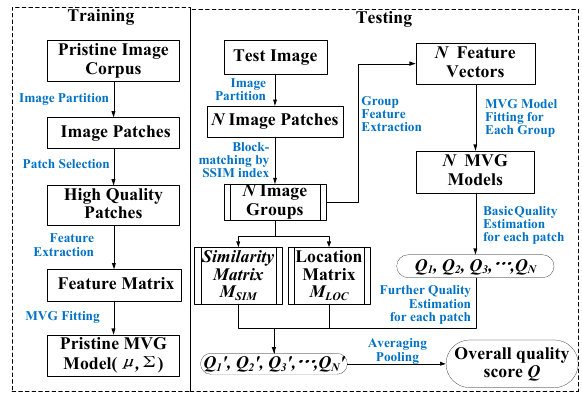
Figure 7. Processing flow of the BM-IQE model. The training stage is required to run before the testing stage. The output model ( μ , Σ ) of the training stage is used for the calculation of Q i in the testing stage. Algorithm 1 BM-IQE